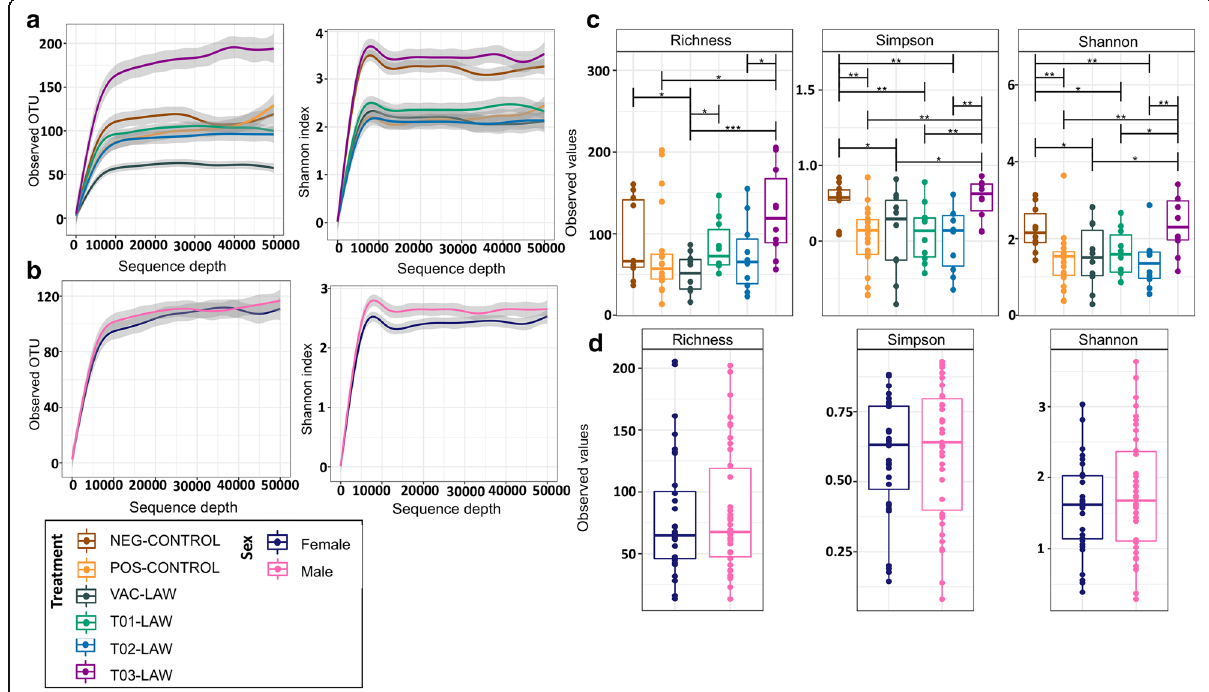
Fig. 1 Changes in the ileal microbial structure associated with treatment groups. a Rarefaction curves of alpha diversity indices, i.e. observed OTUs and Shannon index, grouped by treatment. b Rarefaction curves of alpha diversity indices grouped by gender. c Boxplots of pairwise comparison of the treatment alpha diversity indices using Wilcoxon ’ s non-parametric test where asterisks represent an adjusted P value less than 0.05*, 0.001**, 0.0001***. d Boxplots of the gender alpha diversity